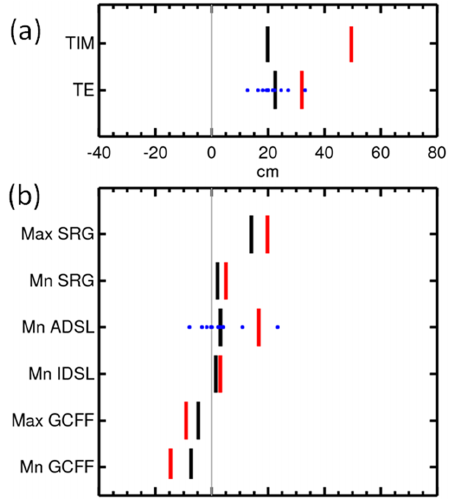
Figure 4. Comparison of contributions to the 21st century change in 50-year storm surge height around NW Europe (centimetres). (a) Global mean contributions, (b) local contributions. Black bars indicate the representative mid-range, and red, the illustrative high- end contributions. Blue dots show the individual ensemble members where these are available. The abbreviations used in the figure are those given in Tables 1 and